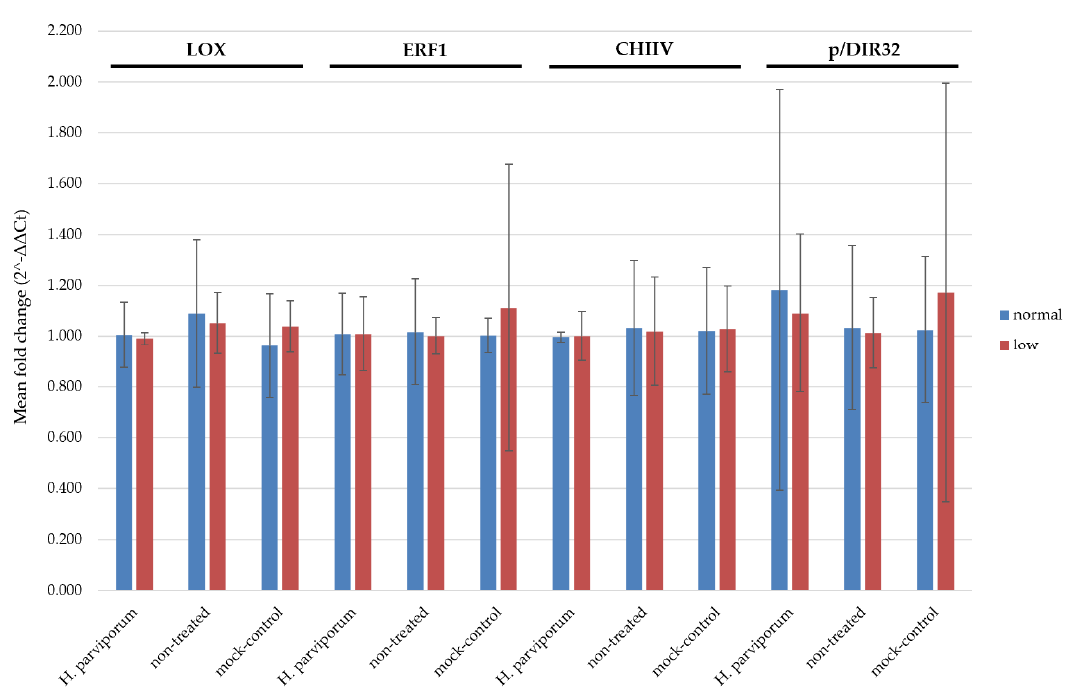
Figure 4. Overview of qRT-PCR mean fold change for each tested gene against ELF1. Variation between triplicate samples of each treatment group was represented by error bars (+/ − SD of each triplicate) respectively.